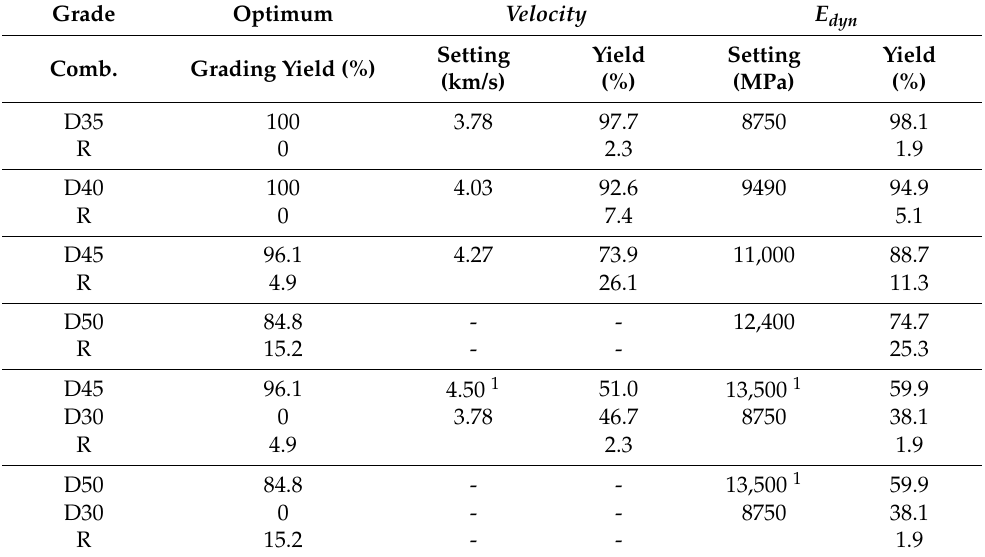
Table 4. Settings and yields for the optimum grading (based on the real properties determined by destructive tests) and machine grading for several grade combinations (R =